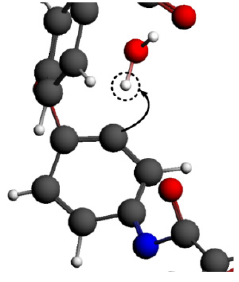
Figure 21. Hydrogen abstraction mechanism of ∙ OH.